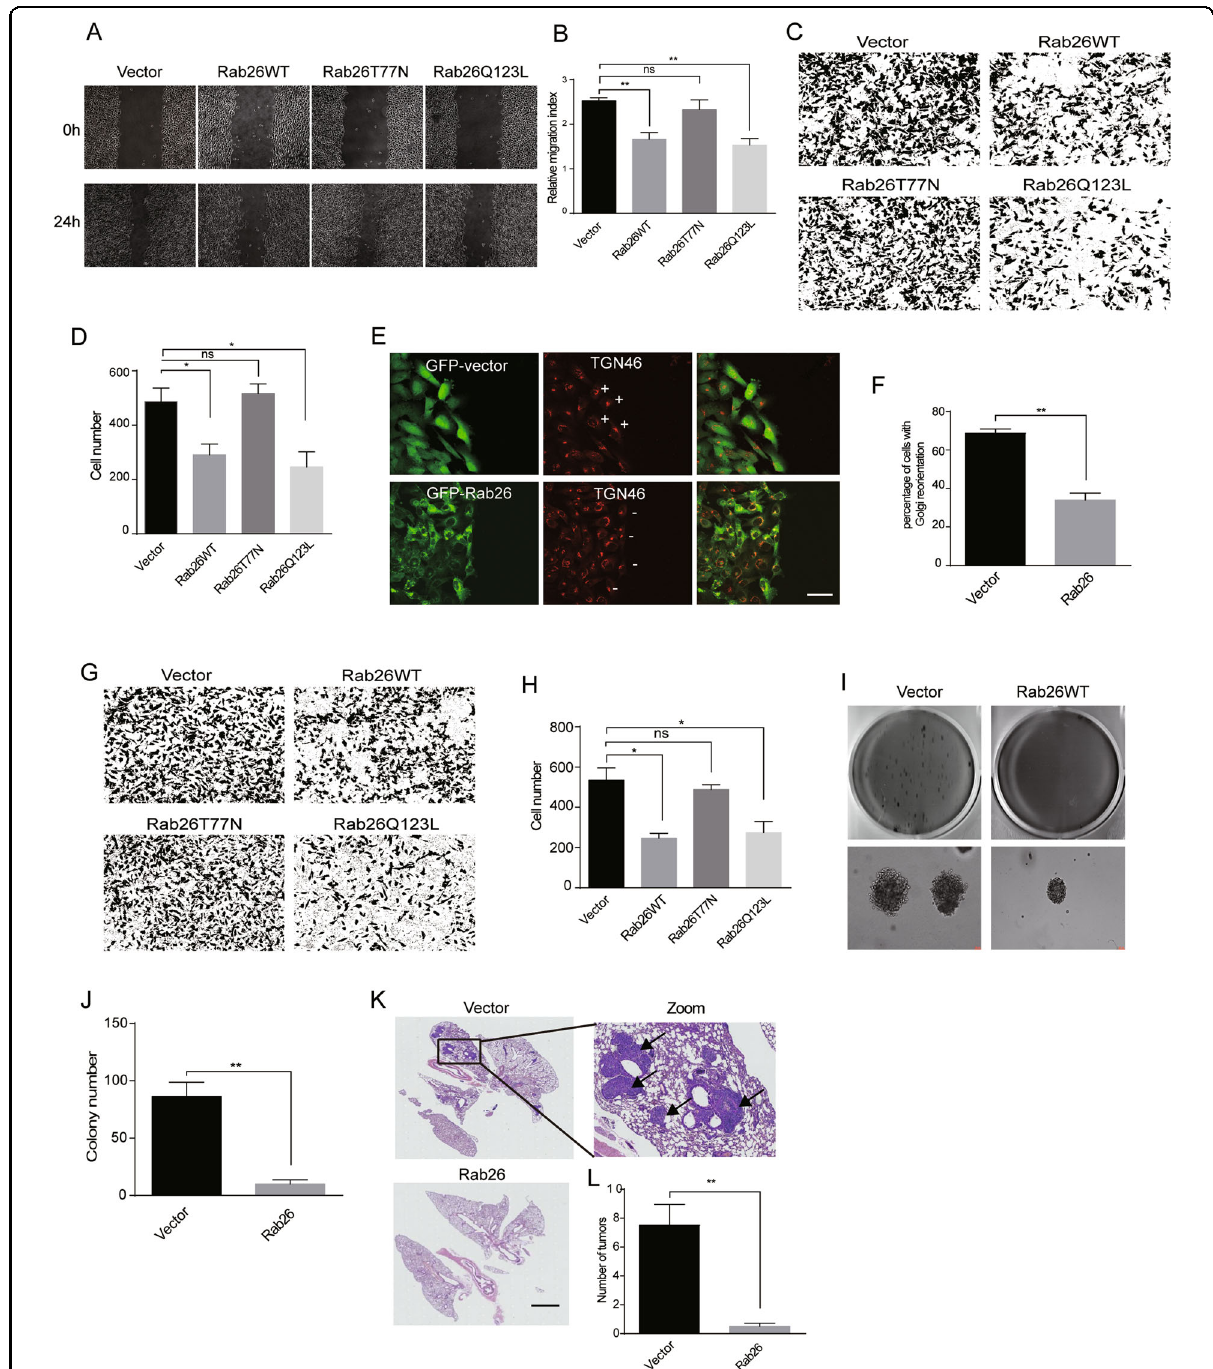
Fig. 2 Rab26 Inhibits migration and invasion of breast cancer cells. A Wound-healing assay revealed that over-expression of Rab26 inhibits migration of MDA-MB-231 cells. B Quantitative analysis of the wound area using imageJ software from three independent wound-healing experiments, ** p <0.01. C Transwell assays showed Rab26 over-expression inhibits migration of MDA-MB-231 cells. D Quantitative analysis of the results of C from three independent experiments, * p <0.05. E Rab26 alters Golgi reorientation during migration in MDA-MB-231 cells. The Golgi apparatus was labeled with TGN46 antibody, bar = 20 μ m. “ + ” and “ − ” means the Golgi facing in the direction of migration or not, respectively. Bar = 50 μ m. F Quantitative analysis of the results of E from three independent experiments, ** p <0.01. G Matrigel assay showed Rab26 inhibits invasive ability of MDA-MB-231 cells. H Quantitative analysis of the results of G from three independent experiments, * p <0.05. I Over-expression of Rab26 inhibits colony formation of MDA-MB-231 cells in soft agar. J Quantitative analysis of I from three independent experiments, ** p <0.01. K HE staining demonstrated that over-expression of Rab26 inhibits the metastasis of MDA-MB- 231 cells and tumor formation in lung tissues of nude mice. Arrows indicates the tumors, bar = 3000 μ m. L Quantitative analysis of K , n = 5. ** p